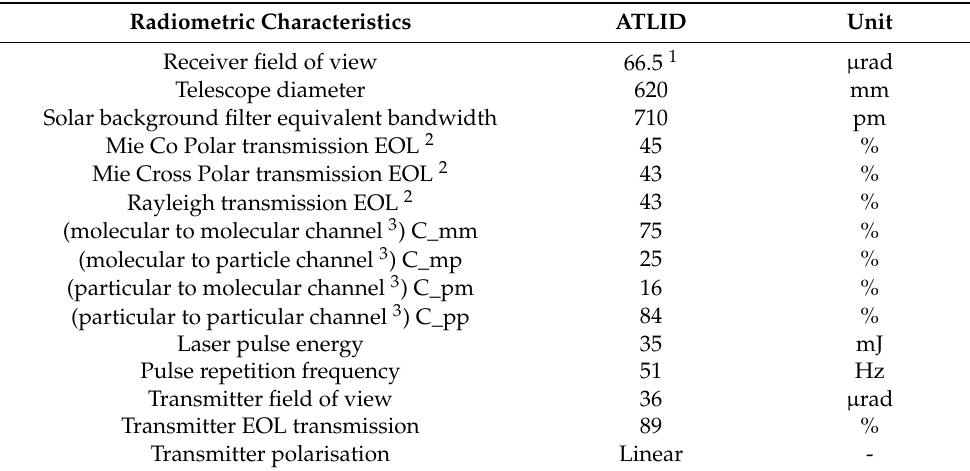
Table 1. ATLID radiometric characteristics.